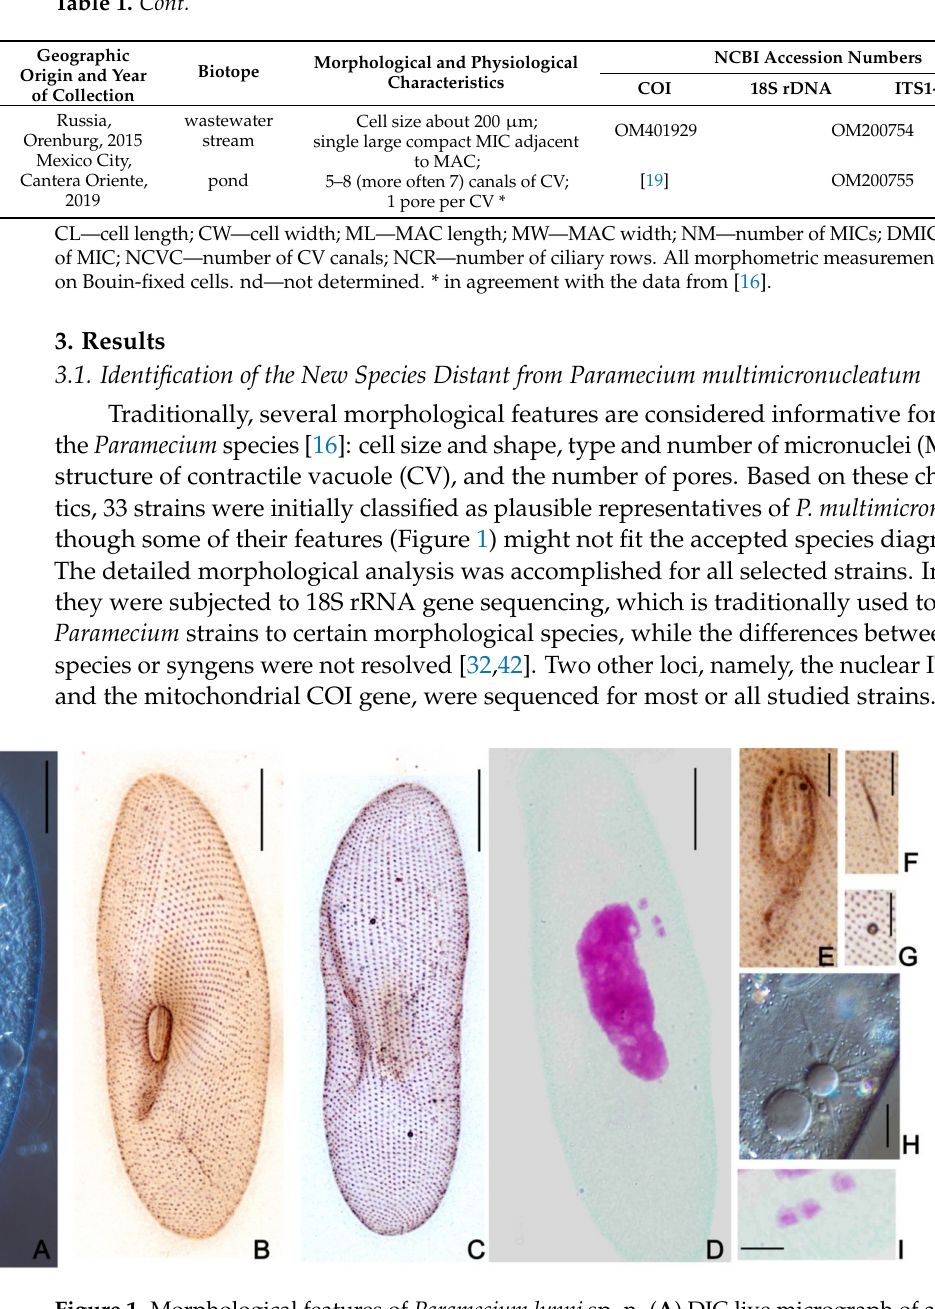
Figure 1. Morphological features of Paramecium lynni sp. n. ( A ) DIC live micrograph of a specimen. Silver nitrate impregnated cells: ( B , C ) ventro-lateral and dorso-lateral cell projections; ( D ) Feulgen stained specimen with three MICs; ( E ) buccal overture with buccal ciliature; ( F ) cytoproct